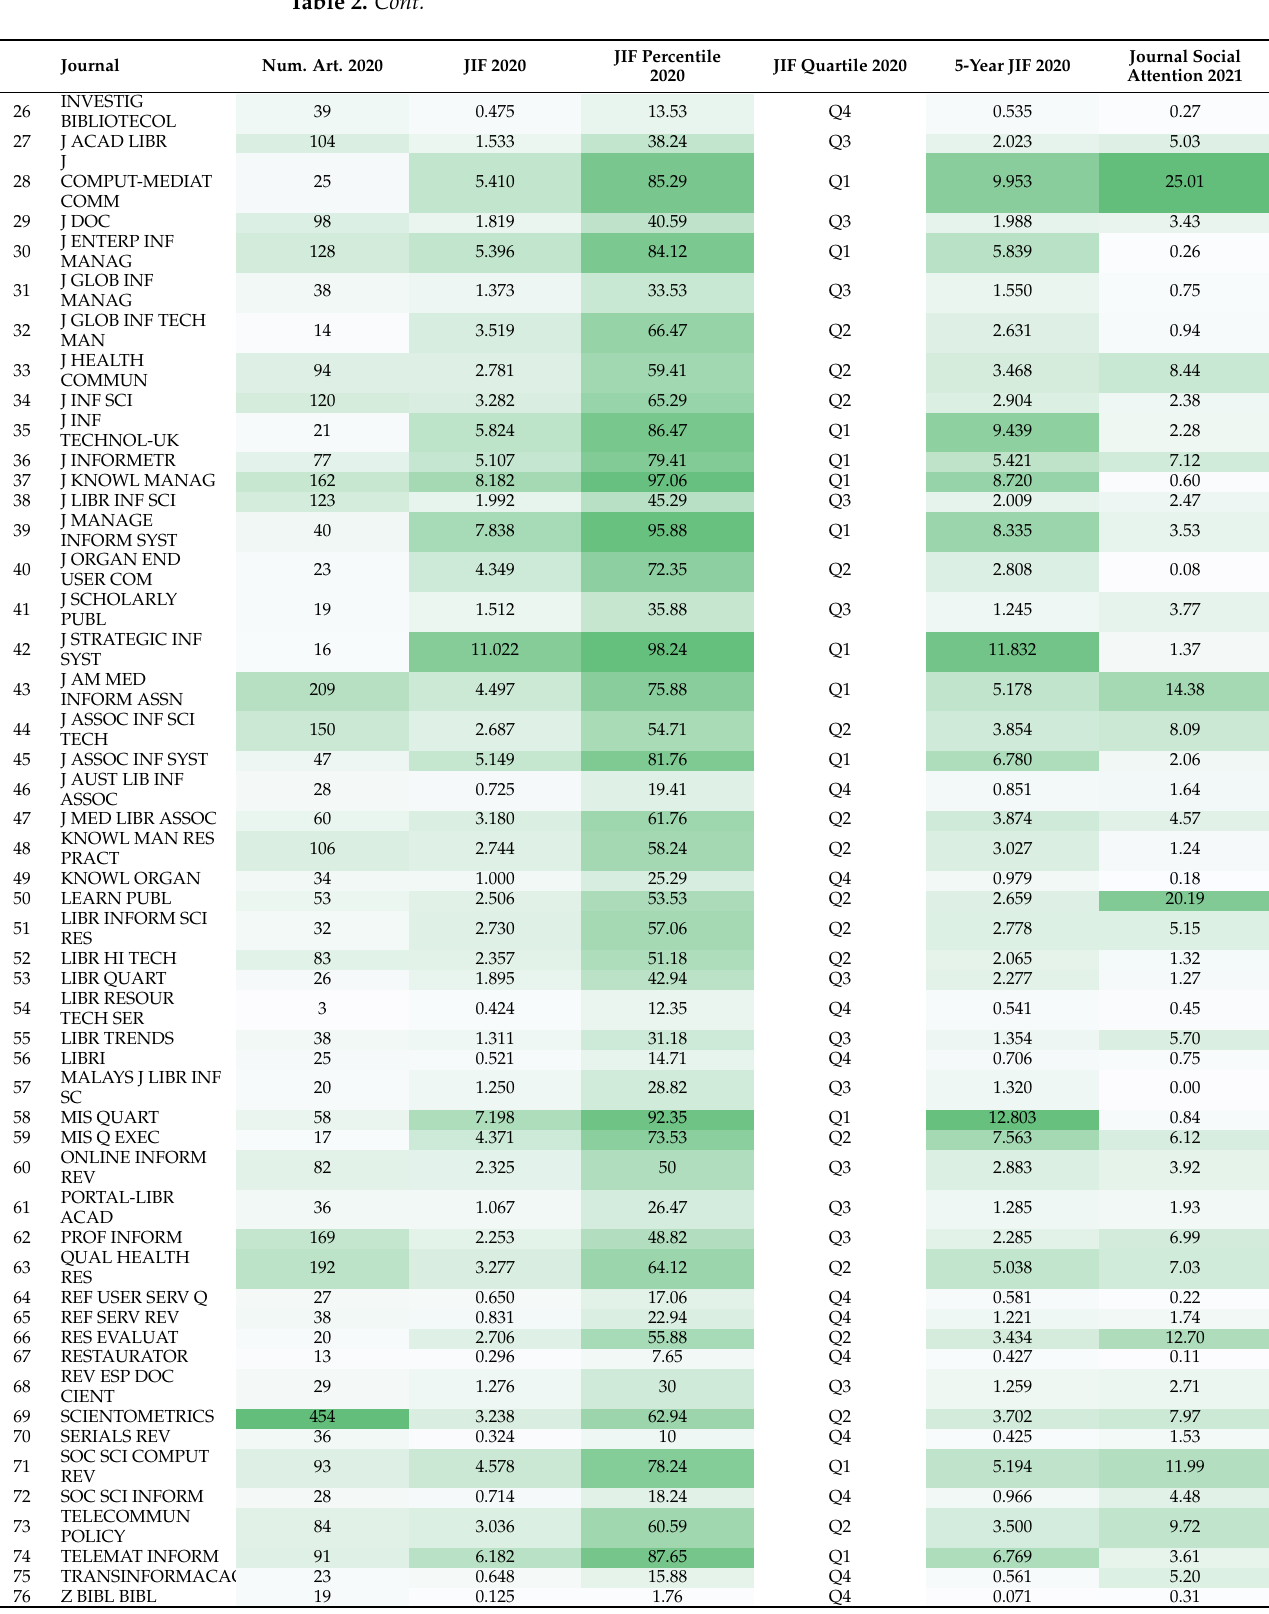
Note. The shade of green corresponds to the magnitude of each number relative to the other values in its column. As such, the larger the number, the deeper the green hue used to represent